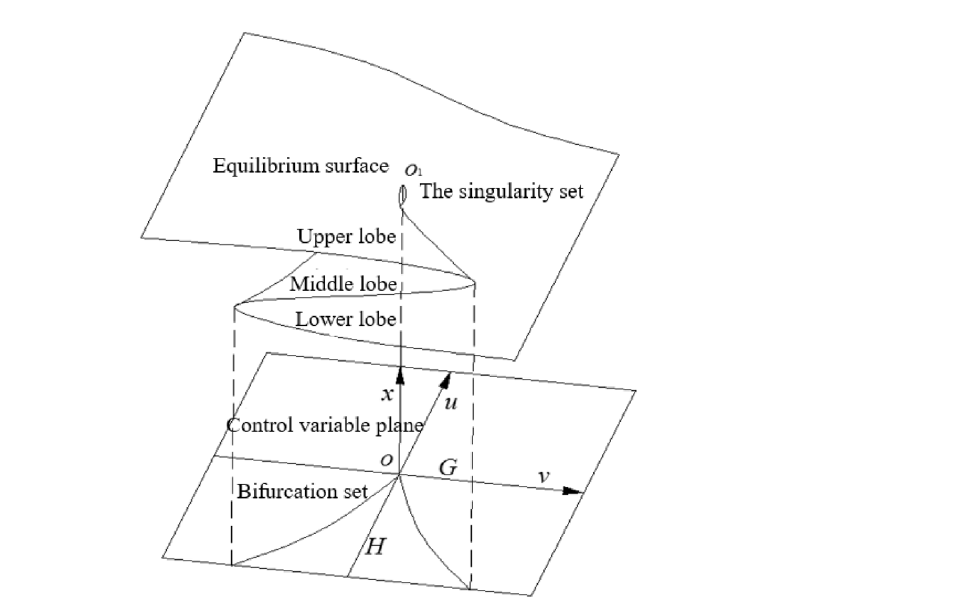
Figure. 9. Equilibrium surface and bifurcation set of the cusp mutation